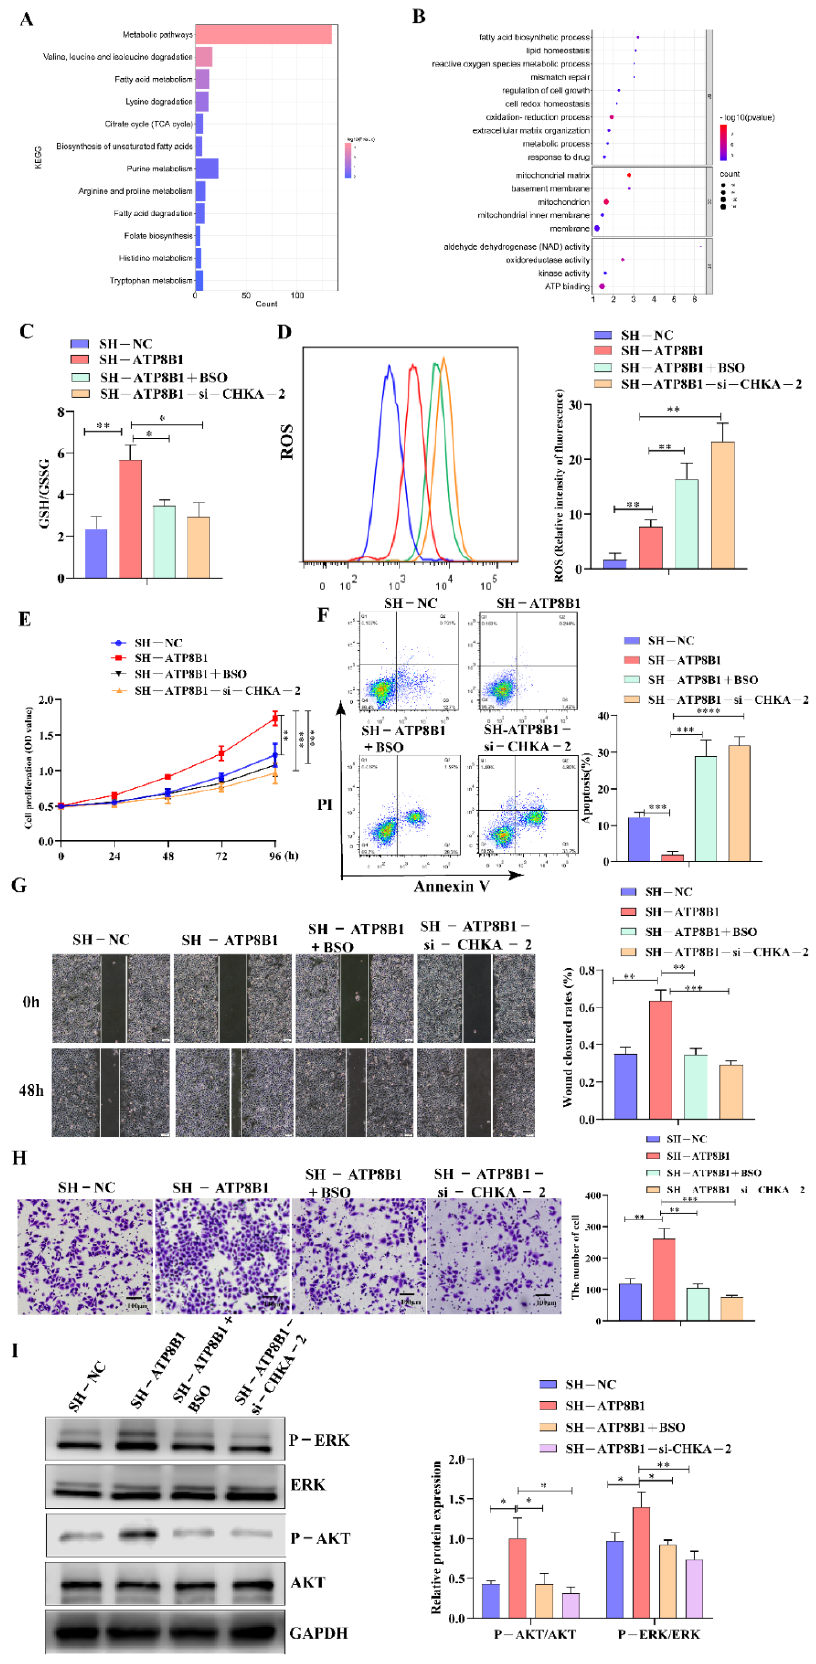
Figure 5. CHKA maintains REDOX balance by regulating the level of intracellular GSH. ( A ) KEGG